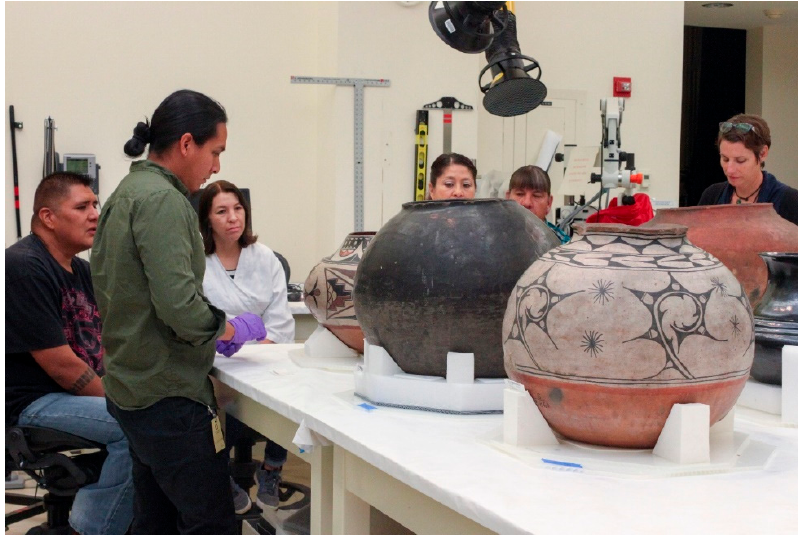
Figure 2. Reviewing pottery for the loan. (left to right, clockwise) Karl Duncan (Poeh Executive Director), David Trujillo (Advisor), Lynda Romero (Poeh Collections Manager), Martha Romero (Advisor), Erik Fender (Advisor), and Kelly McHugh (National Museum of the American Indian Collections Manager). Used by permission of the Smithsonian Institution, National Museum of the American Indian.